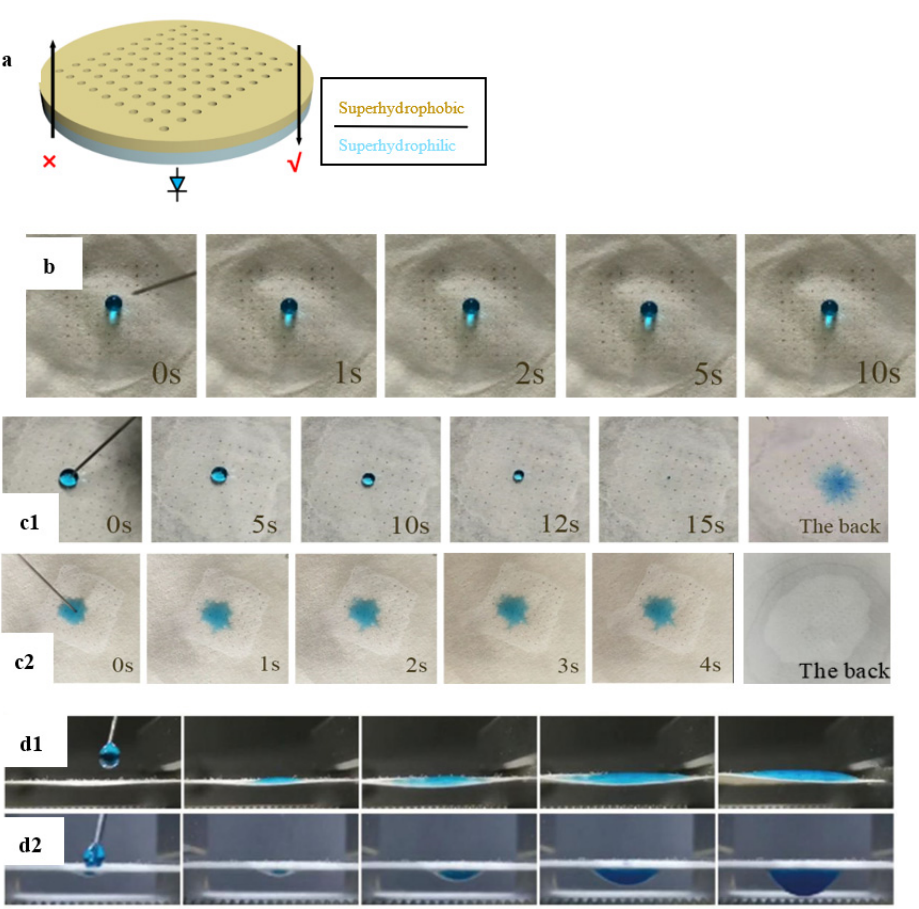
Figure 7. ( a ) Schematic of the the laser-treated paper samples. ( b ) Still frames taken from a video to show the dropping of blue-dyed water onto the UV-irradiated “upper” surfaces for the Janus paper (100 µ m) after UV irradiation about 1 h. ( c ) Still frames taken from a video to show the dropping of blue-dyed water onto the UV-irradiated “upper” ( c1 ) and “below” ( c2 ) surfaces for the Janus paper (100 µ m) after UV irradiation about 1.5 h. ( d ) Still frames taken from a video to show the dropping of blue-dyed water onto the UV-irradiated “upper” ( d1 ) and “below” ( d2 ) surfaces for the Janus paper (300 µ m) after UV irradiation about 1 h.